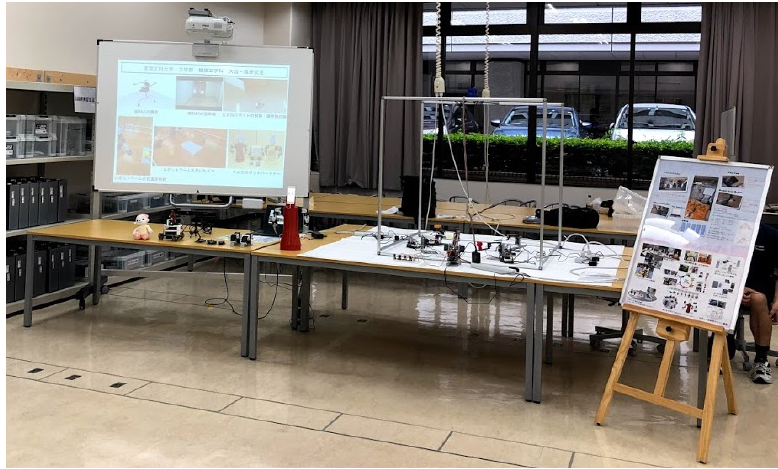
Figure 15. Robot system usage example: Open university guide.